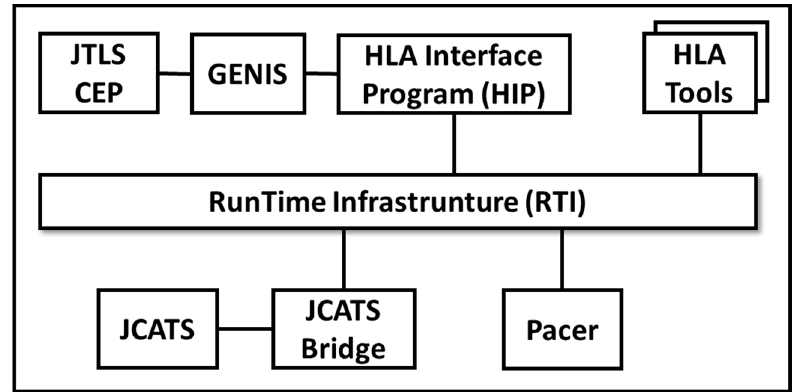
Figure 15. JTLS-JCATS federation (adapted from [45]).